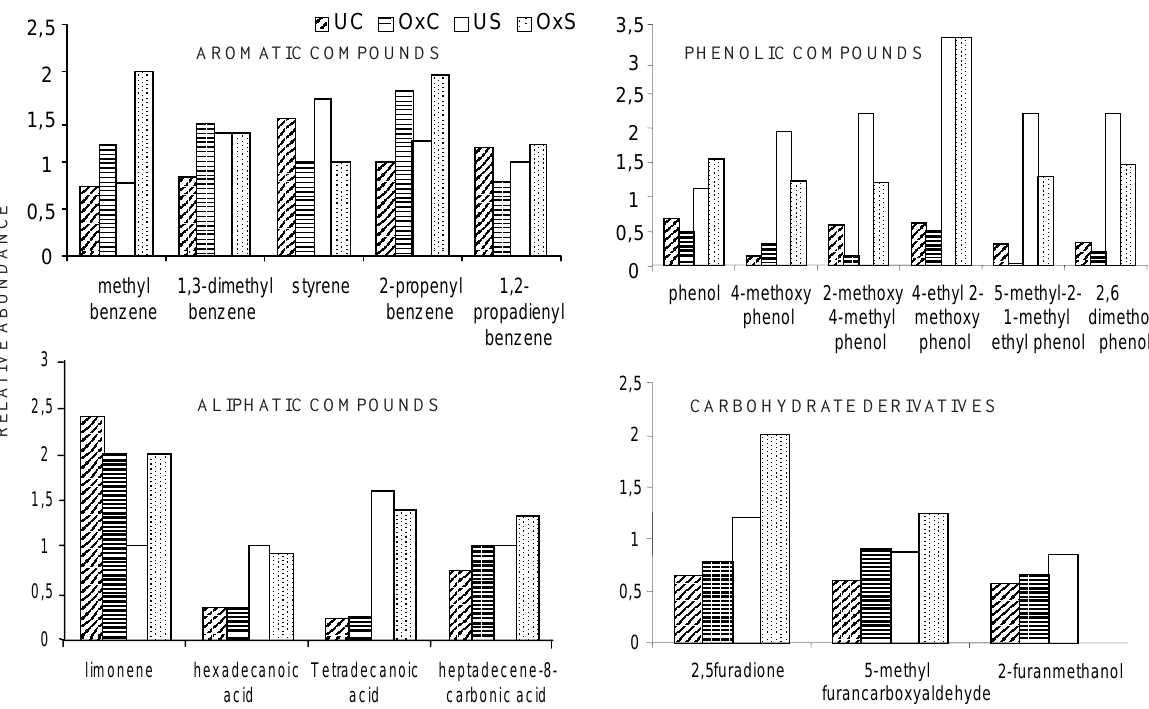
Figure 2. Relative abundance of aromatic compounds, furan derivatives, phenolic and aliphatic compounds in the pyrograms of humic acids from soil samples with and without organic residues. The relative abundance was considered 1 to peak in the chromatograms from HA pyrolitic products without organic residues addition (not shown in the graphics). Abreviattions: Humic acids extracted from: Ox: oxisol; OxC: oxissol with 80 t ha -1 municipal compost, OxS: oxissol with 80 t ha -1 sewage sludge. U: ultisol; UC: ultisol with 80 t ha -1 municipal compost, US: ultisol with 80 t ha -1 sewage sludge.